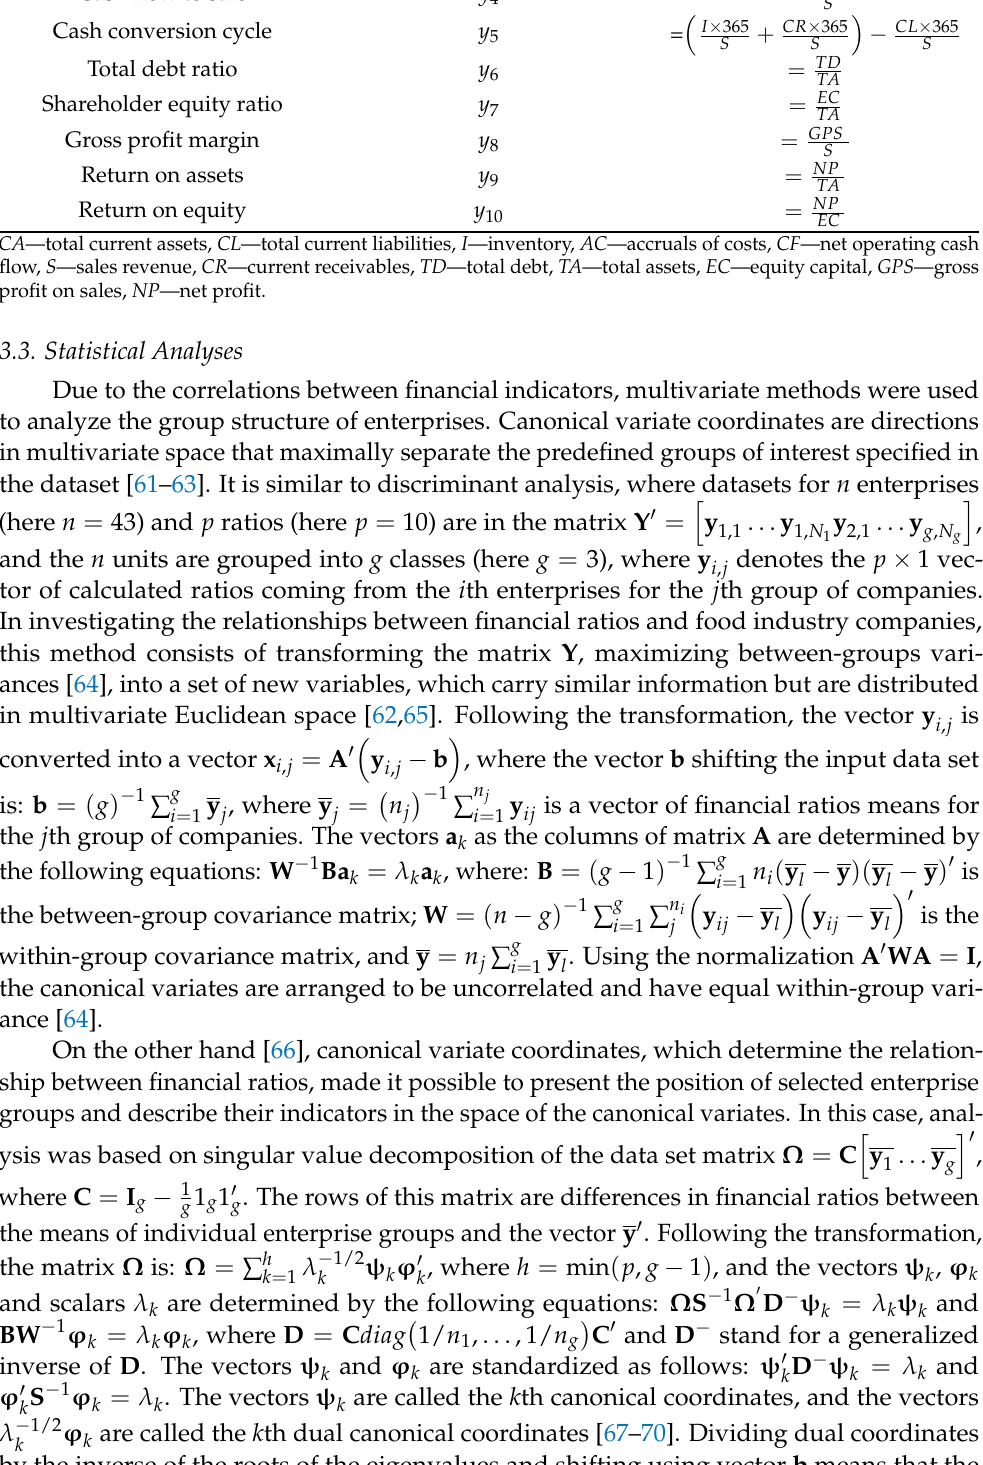
Table 1. Name and construction of the indicators. Name of the Indicator Mark The Formula of the Indicator Current ratio y 1 = CA Quick